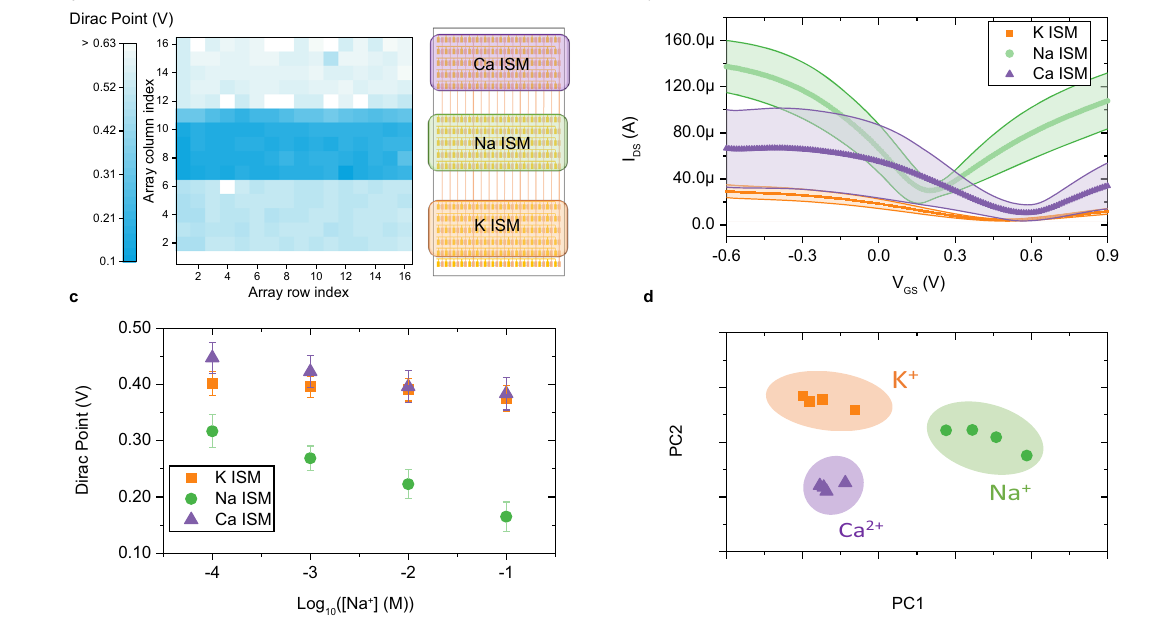
Algorithm-enhanced sensing accuracy